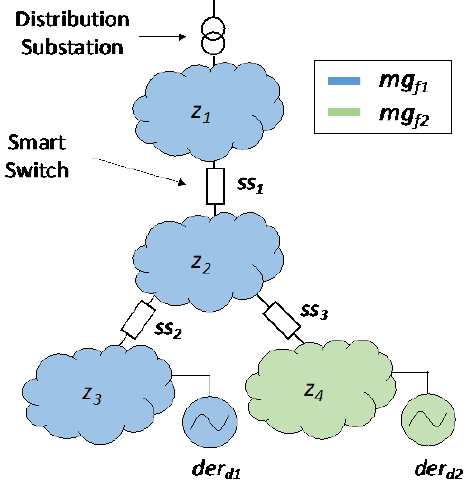
Figure 2. Example of a selected Network Solution.